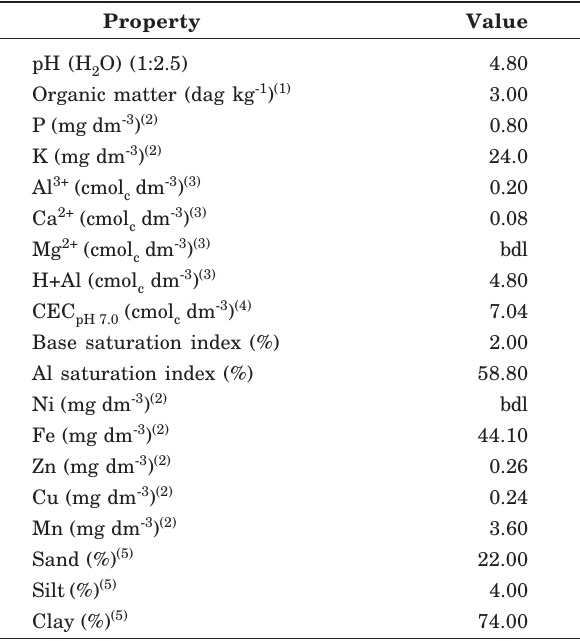
Table 1. Red Yellow Latosol physical and